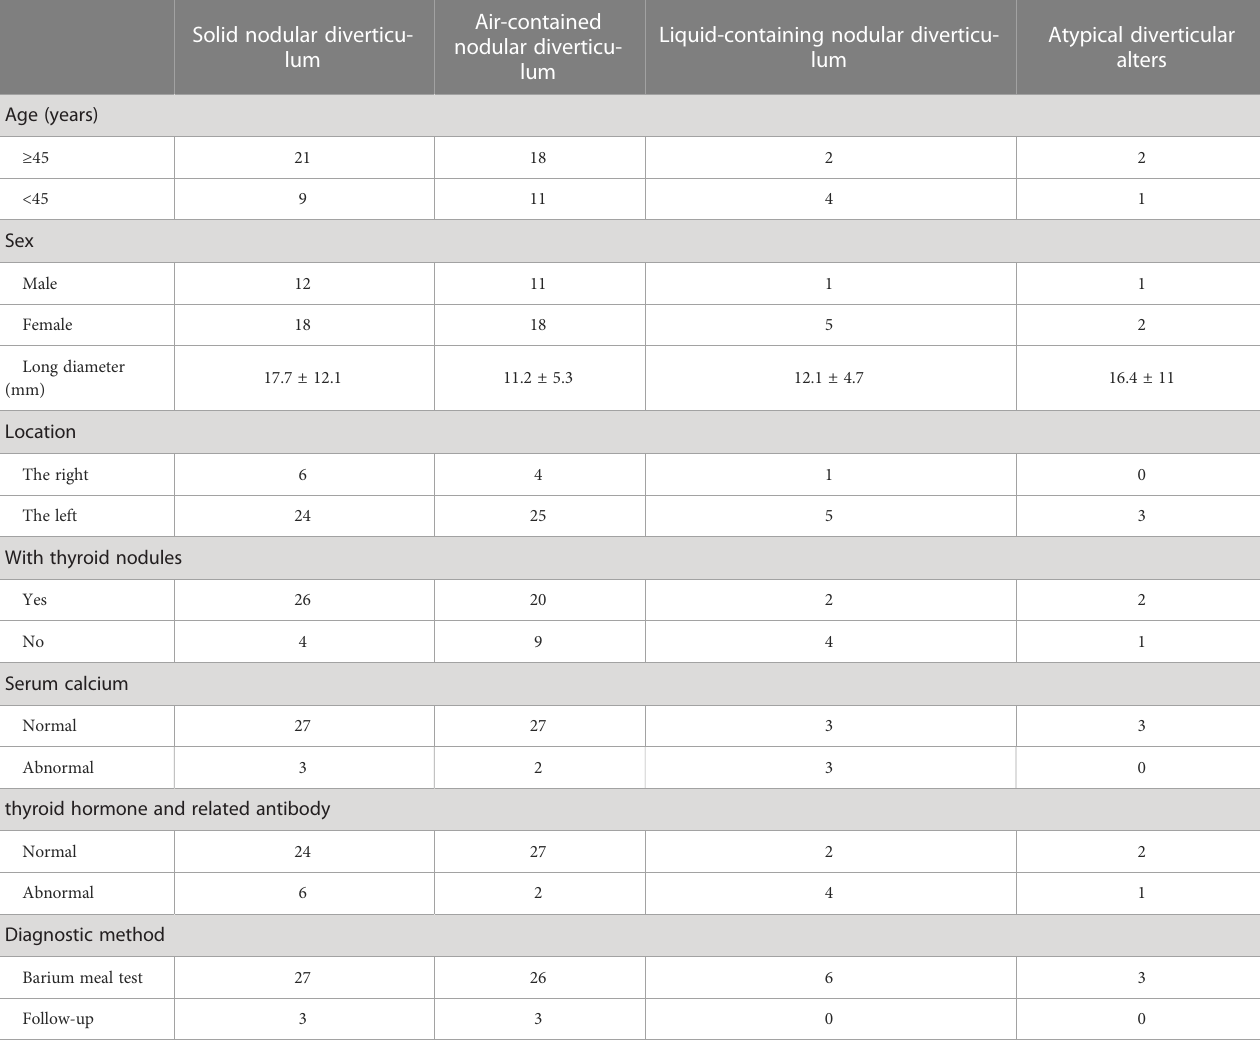
TABLE 1 Physical and laboratory